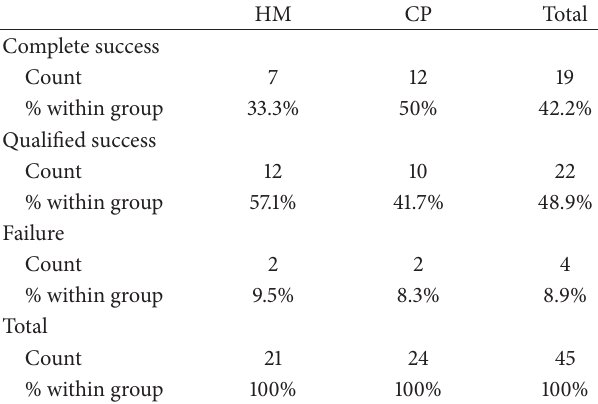
Table 2: Eyes’ distribution according to the clinical outcome at the end of the follow-up.